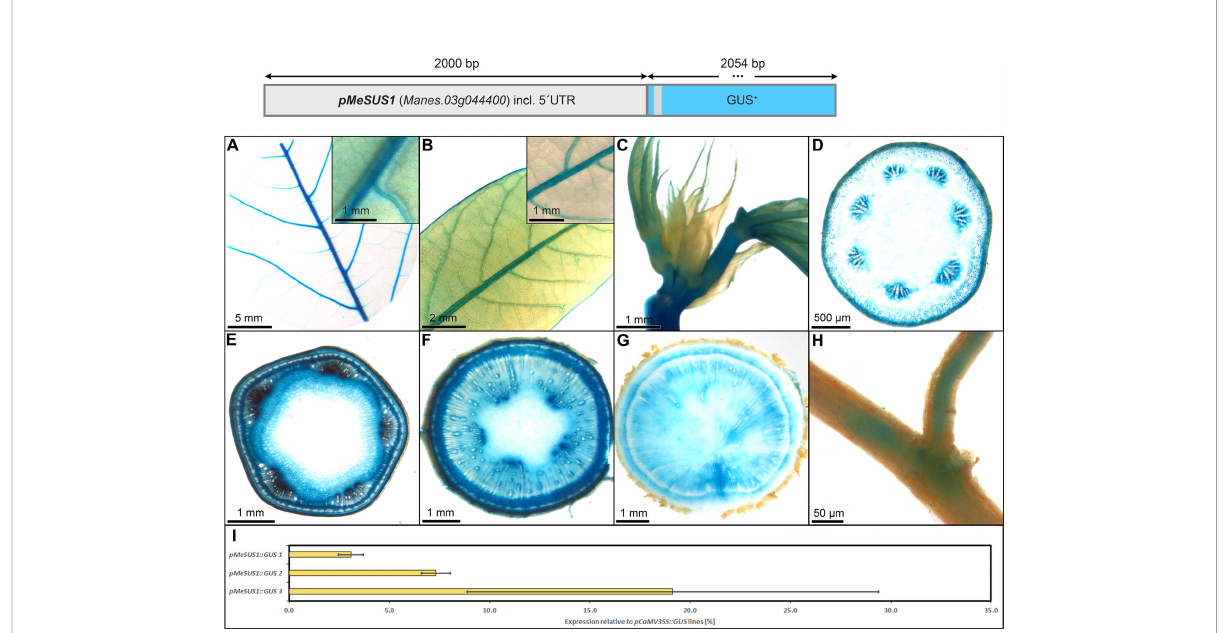
FIGURE 8 Representative GUS staining pattern of at least four pMeSUS1 promoter-reporter lines. (A) Source leaf (Inlay = Close-up), (B) Sink leaf (Inlay = Close-up), (C) Emerging leaves, (D) Petiole cross-section, (E) Upper stem cross-section, (F) Lower stem cross-section, (G) Storage root cross- section, (H) Fibrous roots, (I) GUS expression levels of three pMeSUS1::GUS lines relative to three pCaMV35S::GUS lines in %. Bars represent mean values with standard deviation